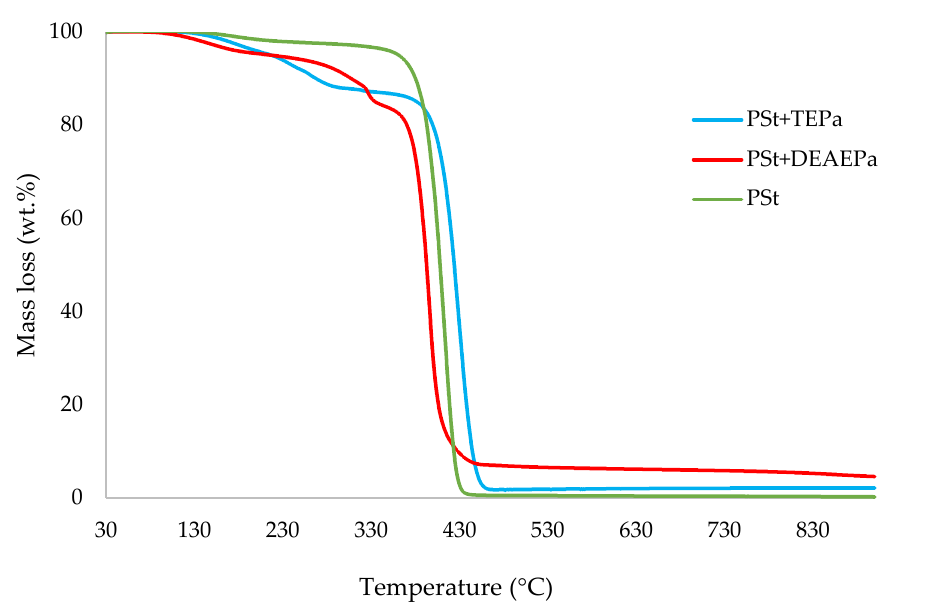
Figure 6. An overlay of the TGA curves of PSt and PSt+phosphate materials, at 10 °C min −1 in nitrogen, from 30 to 900 °C.